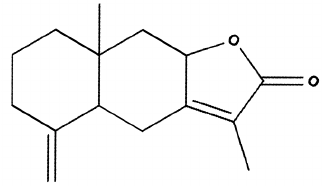
Figure 1. The chemical structure of atractylenolide I.